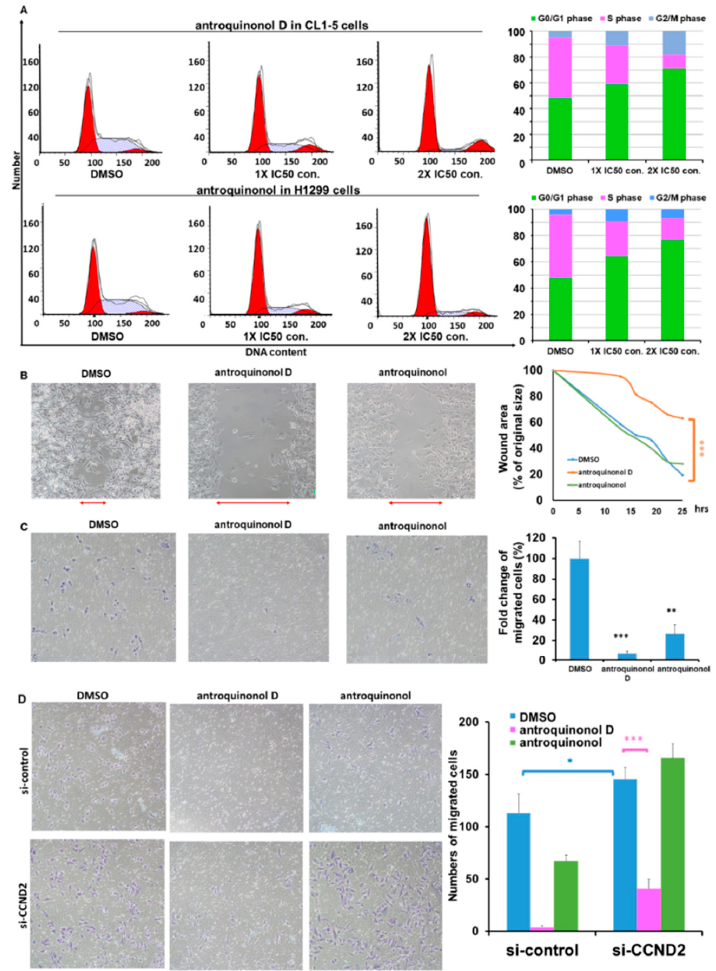
Figure 6. Antroquinonol D suppresses lung cancer cell migration mediated by low CCND2 expression. ( A ) Cell cycle arrest was induced by antroquinonol D in CL1-5 lung cancer cells and by antroquinonol in H1299 lung cancer cells in a dose-dependent manner. Cancer cell migration was inhibited by antroquinonol D and antroquinonol assayed by the wound-healing assay ( B ) and Transwell assay ( C ). ( D ) The Transwell assay was used to analyze cancer cell migration ability following antroquinonol D and antroquinonol treatment for low CCND2 expression. The data are presented as means ± SD * p ≤ 0.05, ** p ≤ 0.01, *** p ≤